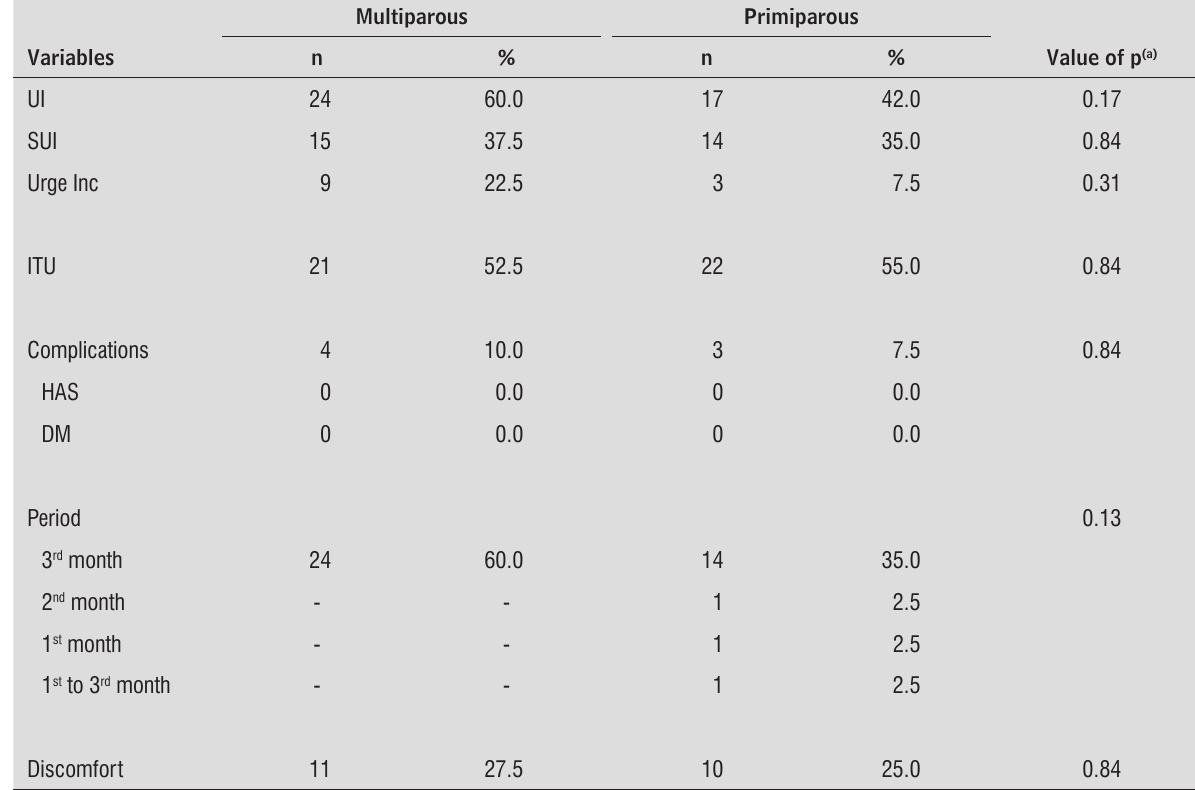
Table 1 - Mean and standard deviation values of clinical and anthropometric parameters